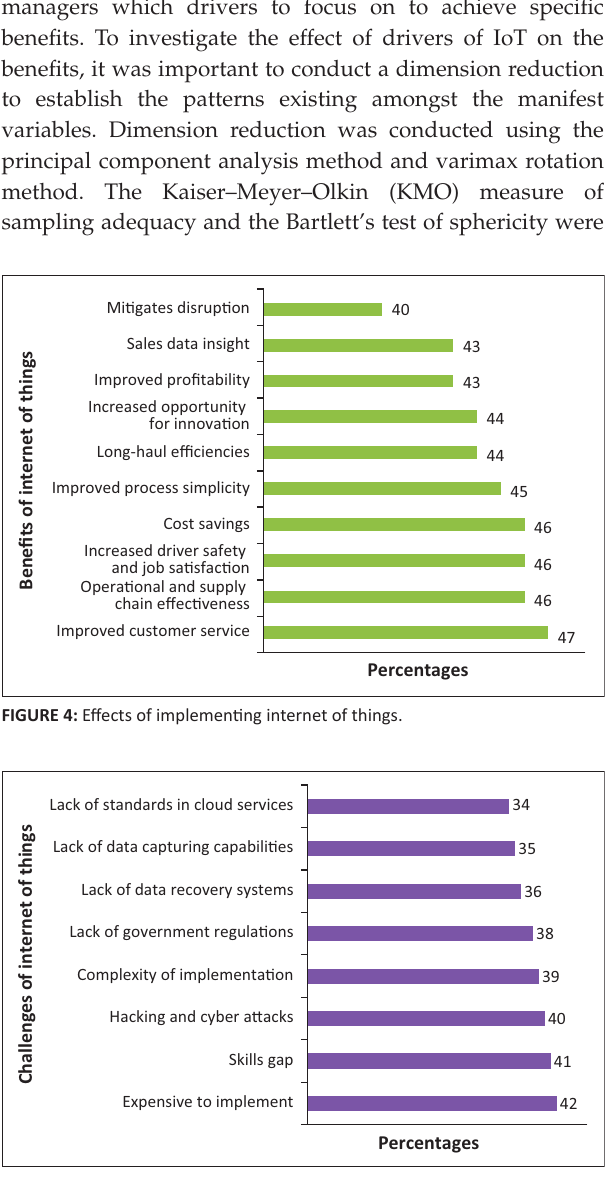
FIGURE 3: Drivers of implementing internet of things.